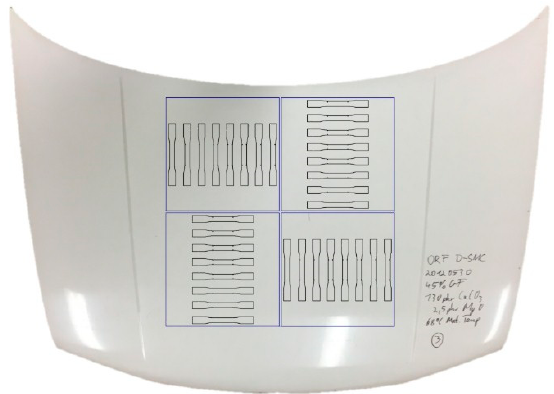
Figure 2. Depiction of the position of rectangular sheets and tensile specimens cut from a full-sized car hood.